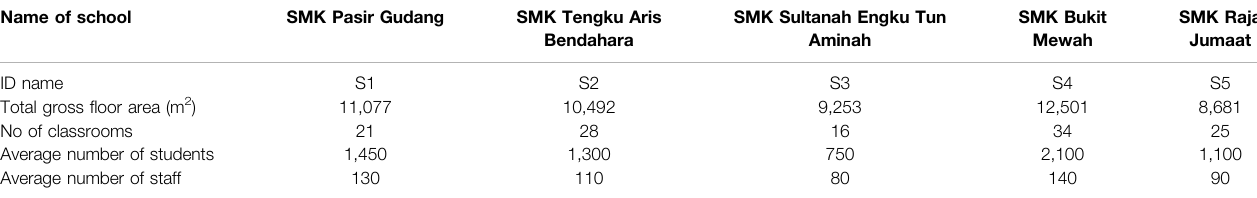
TABLE 2 | Background data of the